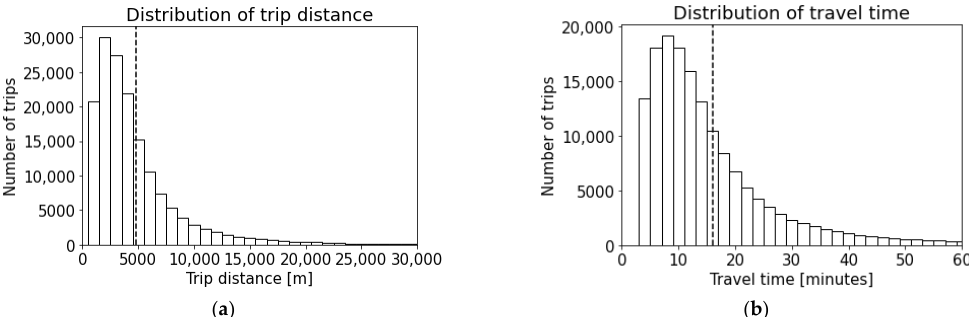
Figure 1. The distribution of trip distance ( a ) and travel time ( b ). The average value is represented by the vertical dashed line.